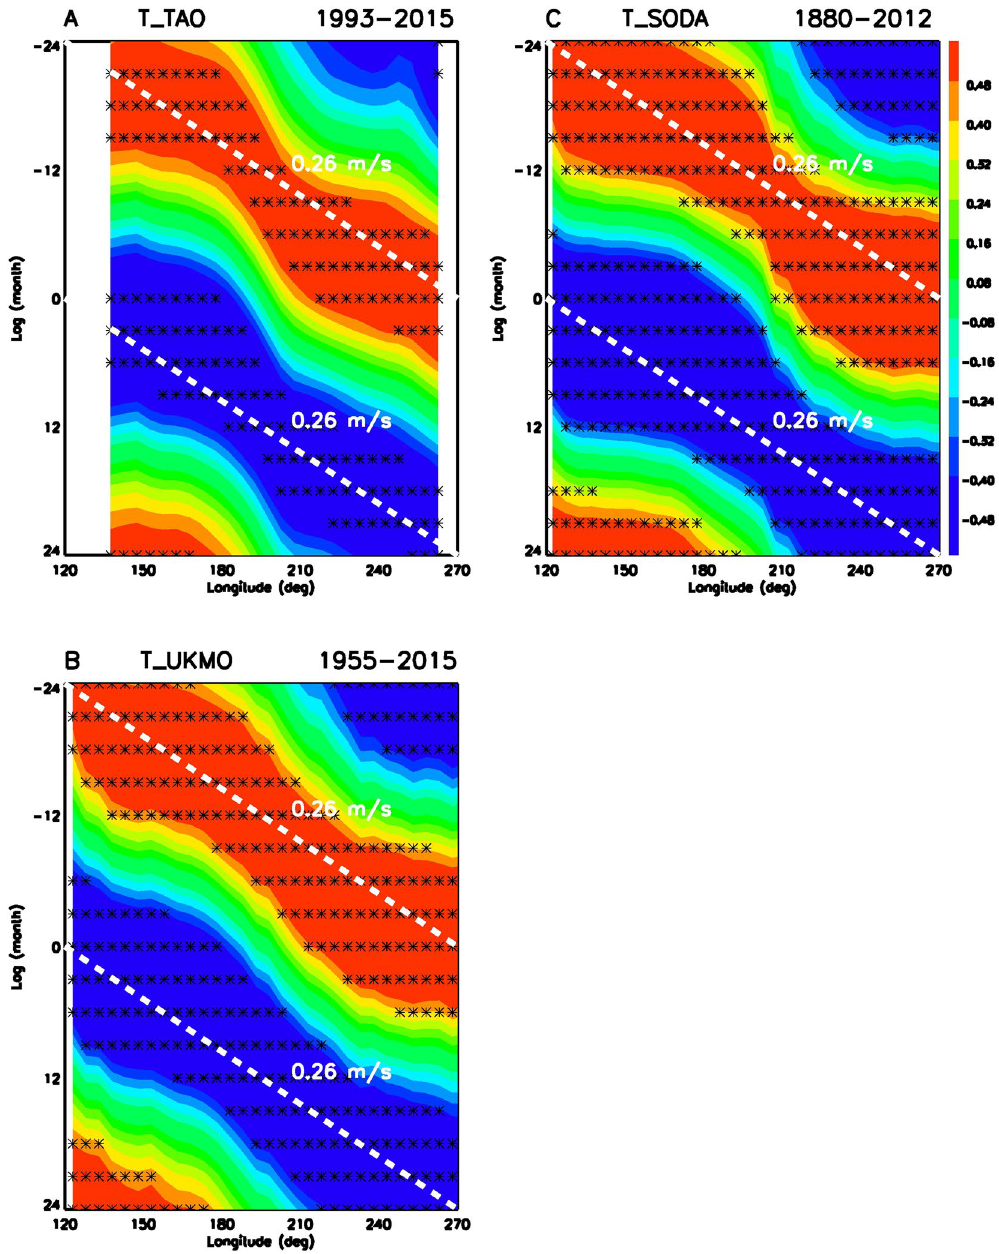
Figure 3. Eastward propagation of ocean subsurface wave along the thermocline associated with ENSO lifecycle in three observational datasets. ( A ) TAO buoy array for 23 years (1993–2015), ( B ) UKMO ocean analysis for 61 years (1955–2015), and ( C ) SODA ocean reanalysis for 133 years (1880–2012). Shadings show lag-correlation with Nino3.4 SST for ocean temperature averaged between 5N-5S along the thermocline (climatological 23.5 °C depth). Black stars denote the grids with lag-correlation above 95% confidence level. White dashed lines are the 0.26 m/s phase speed